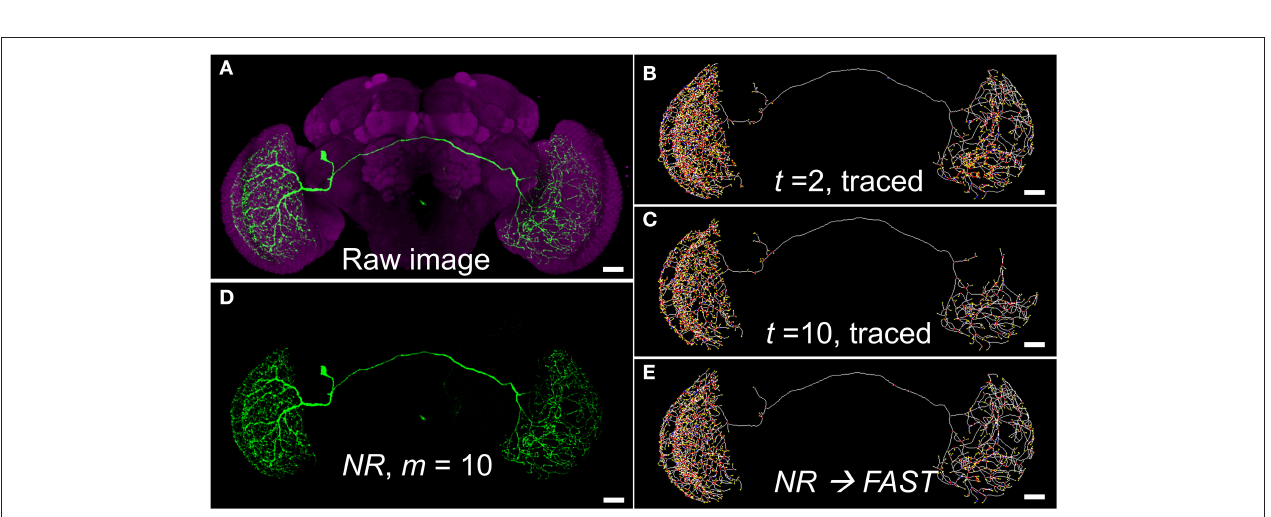
FIGURE 1 | new start point at center (blue). Lower: New branch point (red) determined by retracting two voxels from original codelet branch point (orange). Skeleton determined as serial central points (gray) linking soma (cyan) and branch point (red) to terminals (yellow). (C) Upper: Schematic example of BS calculation with G 0 = 2, L 0 = 2 voxels and N 0 = 3 G 0 = 6. Numbers in voxels are original fluorescent intensity. Gray branches are terminals. Consecutive voxels with same color belong to same branch. Boxes beside branches demonstrate BS calculation. The super- and subscripts of G ( j ) i , N ( j ) i , L ( j ) i , and BS ( j ) k have all been omitted and shortened to G , N , L , and BS, respectively. Lower: Resulting BS for each voxel. Scale bars represent 25 µ m.